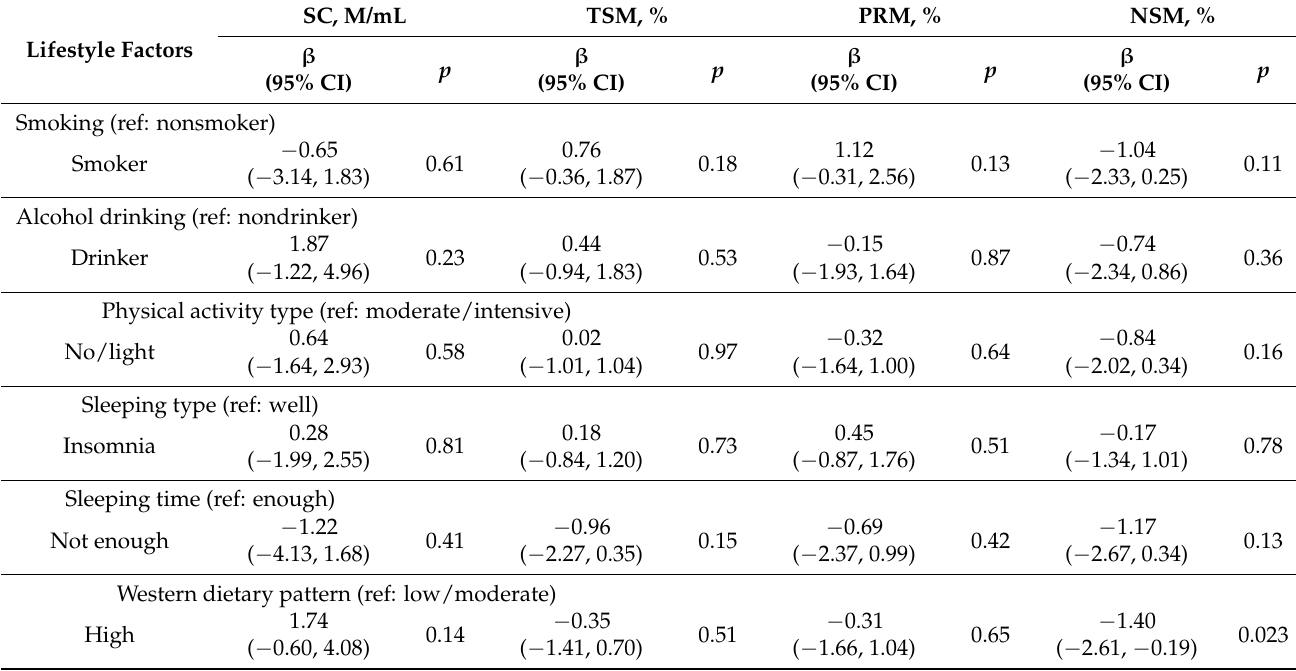
Table 4. Adjusted beta ( β ) coefficient and 95% confidence intervals (CIs) of sperm quality according to lifestyle behaviors.